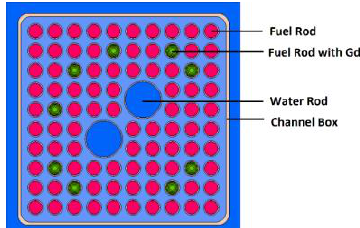
Figure 1. BWR Fuel Assembly